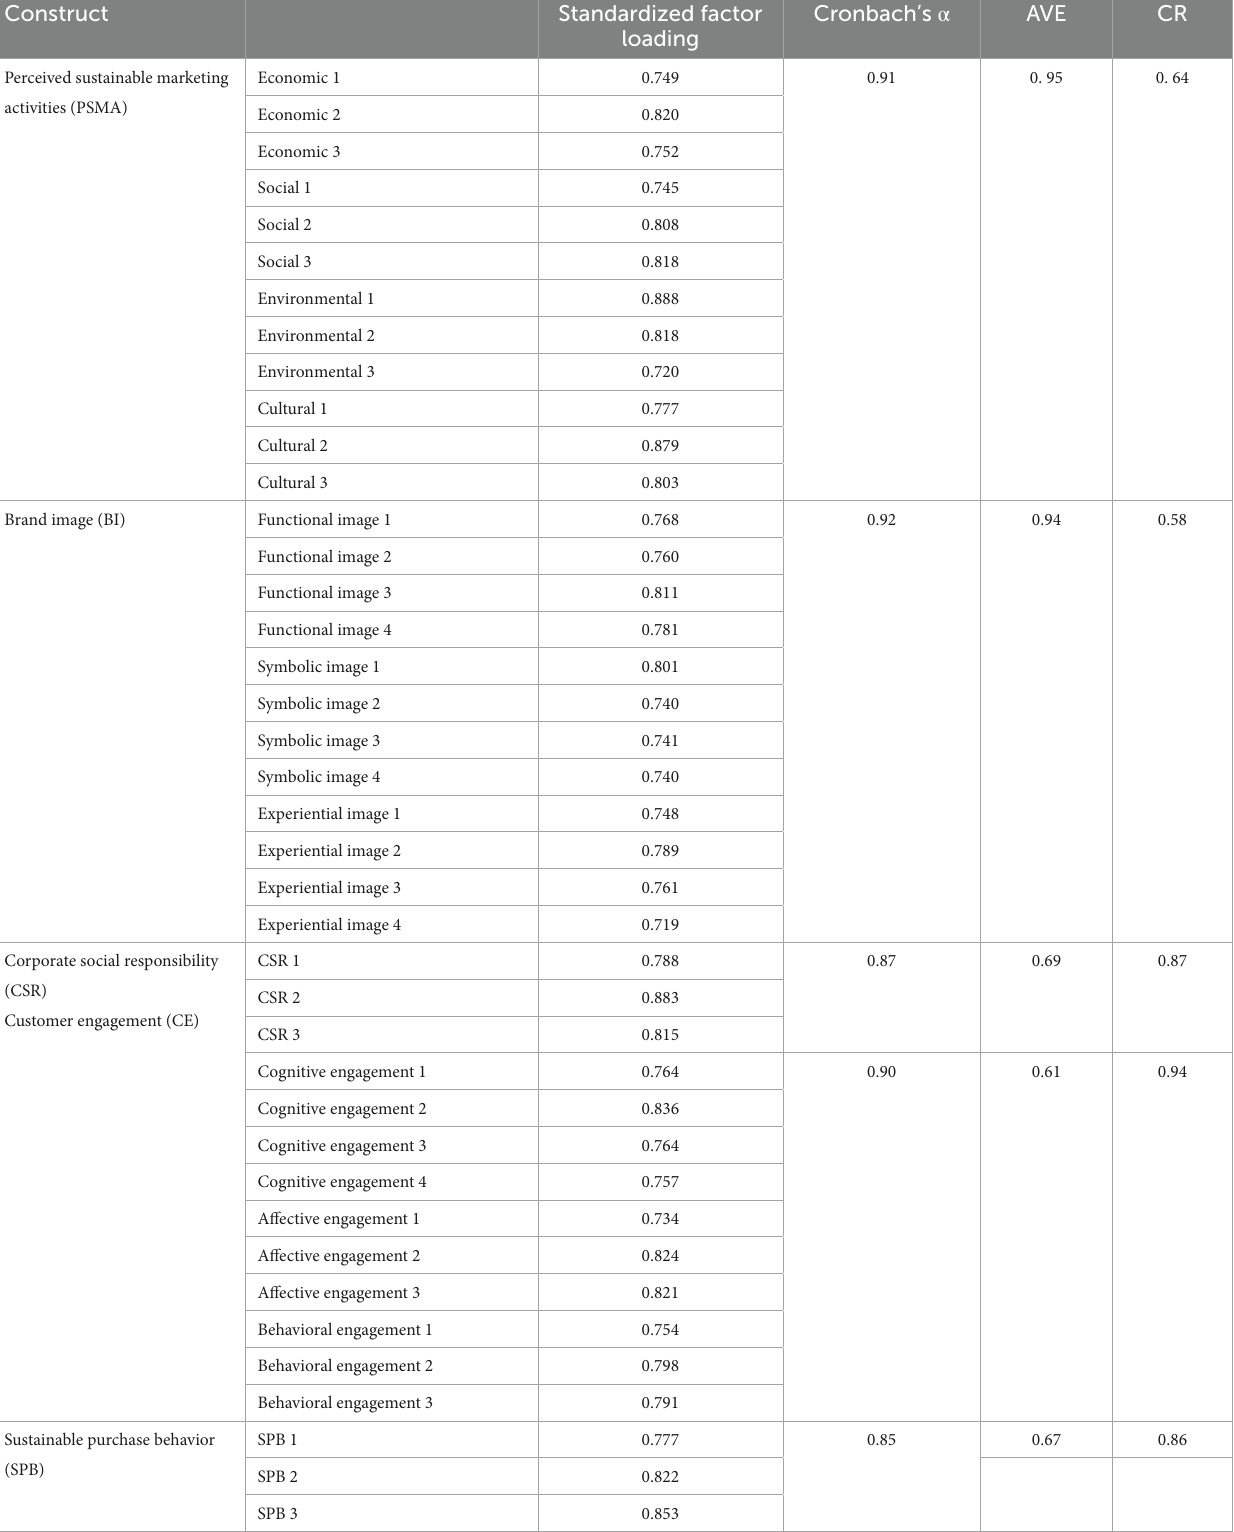
TABLE 1 Results of confirmatory factor analysis for